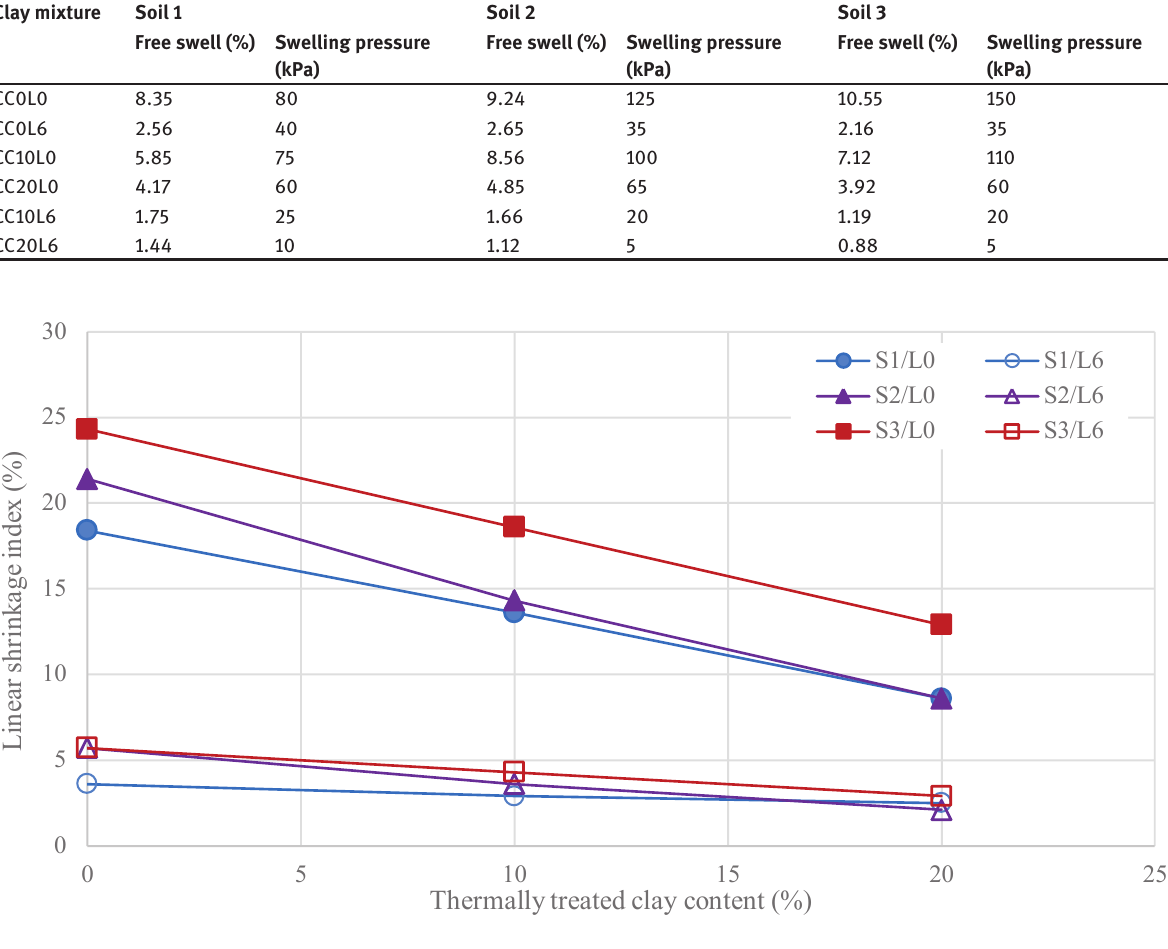
Figure 7. Linear shrinkage index values of the soil mixtures. Figure 7: Linear shrinkage index values of the soil